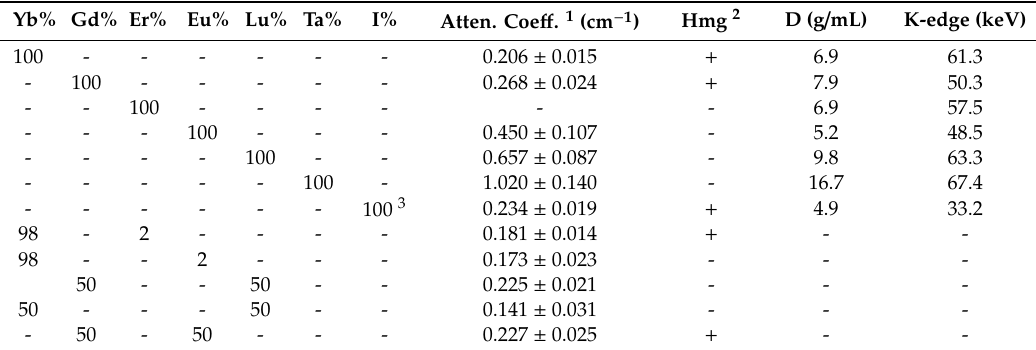
Computed tomography (CT) values and characteristics of the di ff erent synthesized OA-stabilized nanophosphors